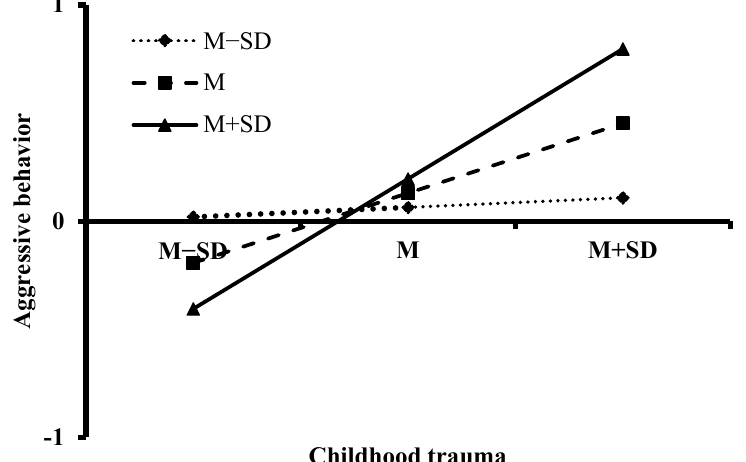
Figure 3. The interaction effect of childhood trauma and psychological resilience on aggression.